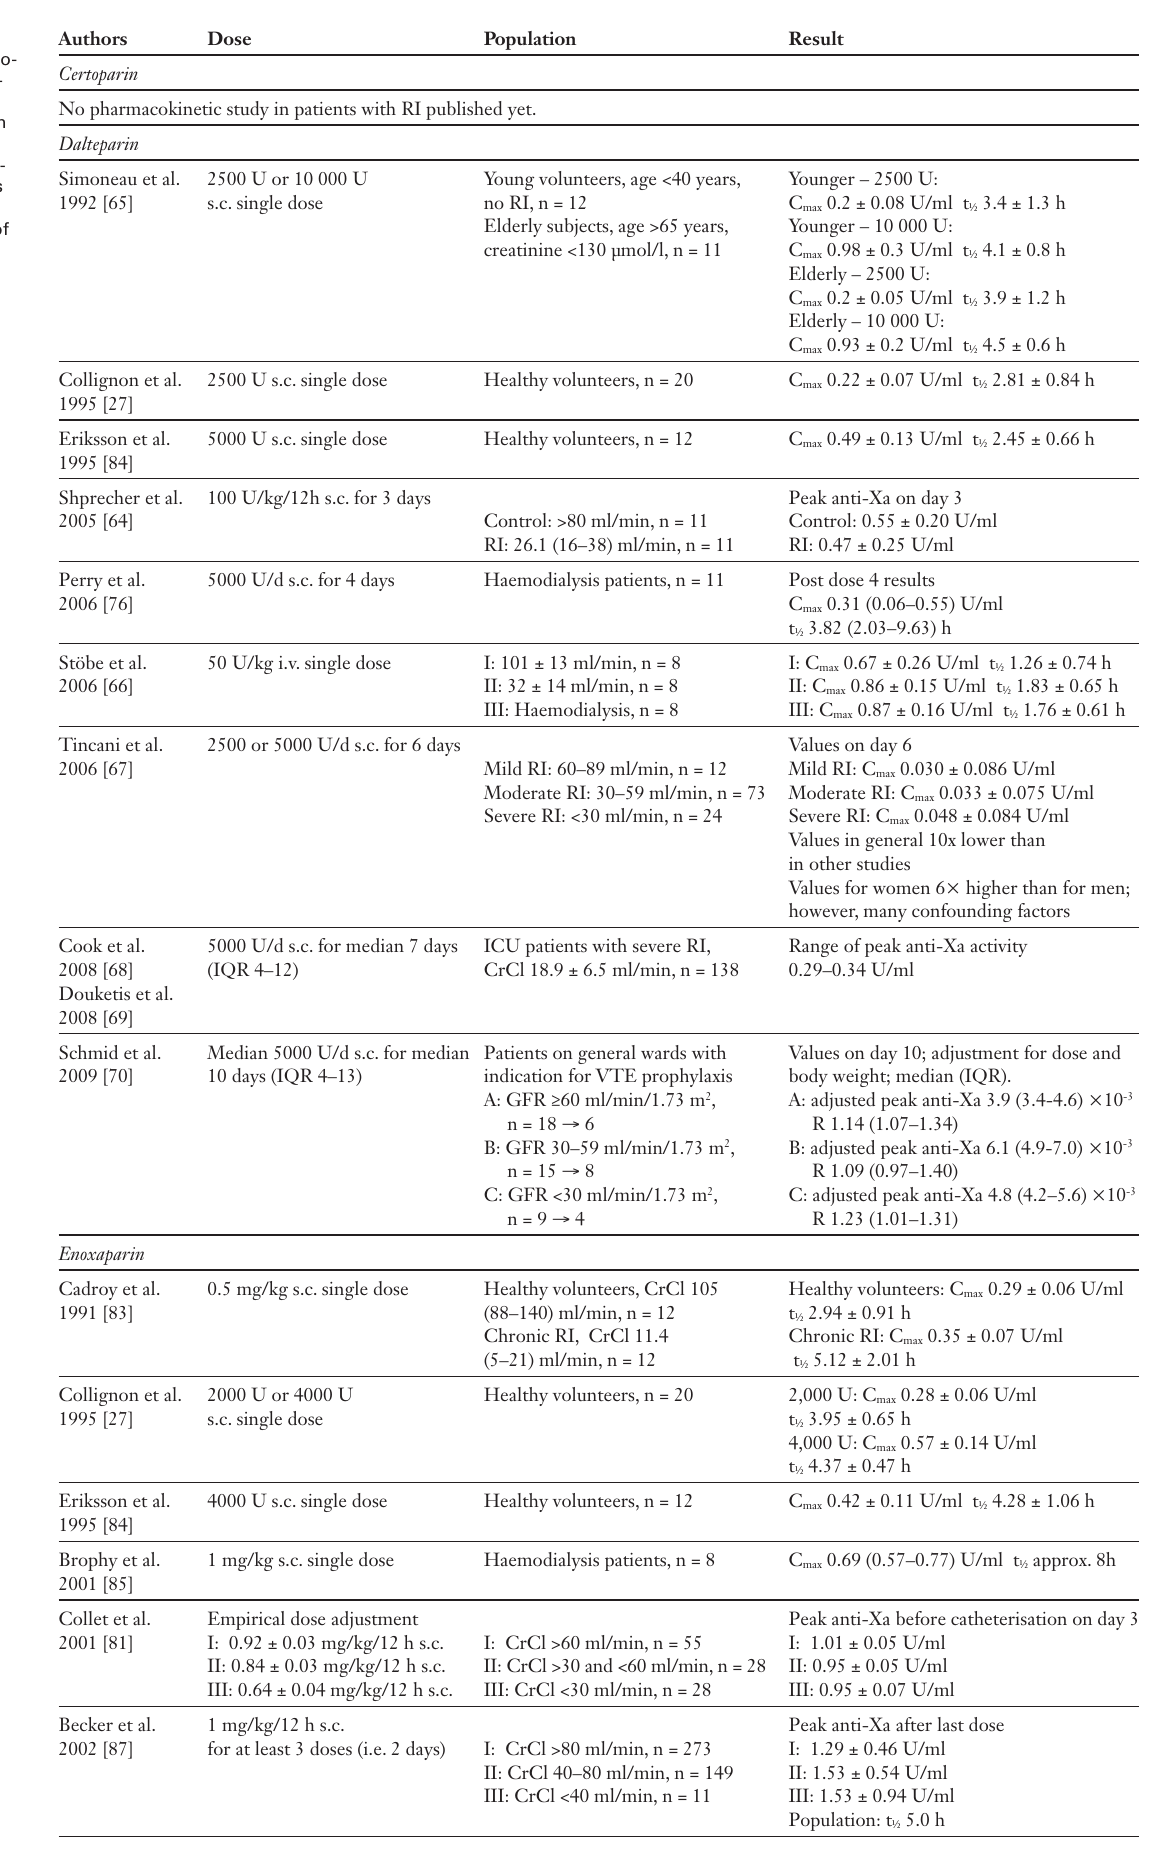
Table 3 Published pharmaco- kinetic data on low- molecular-weight heparins (LMWH) in patients with renal insufficiency (RI) in- cluding two studies [27, 84] comparing pharmacokinetics of various LMWH in healthy